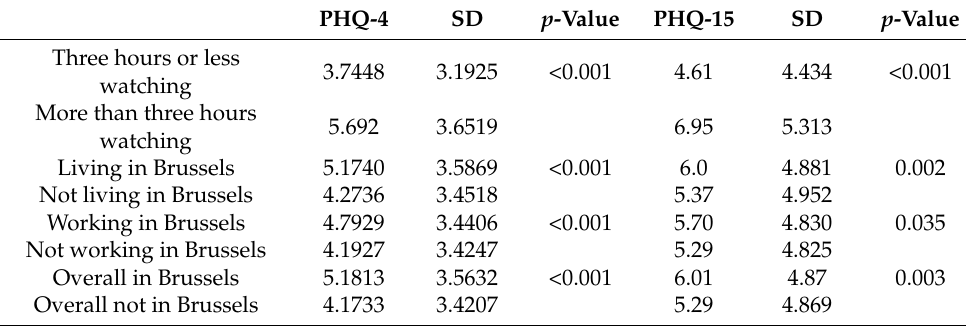
Table 4. Averages of media watching and proximity, with health as outcome.